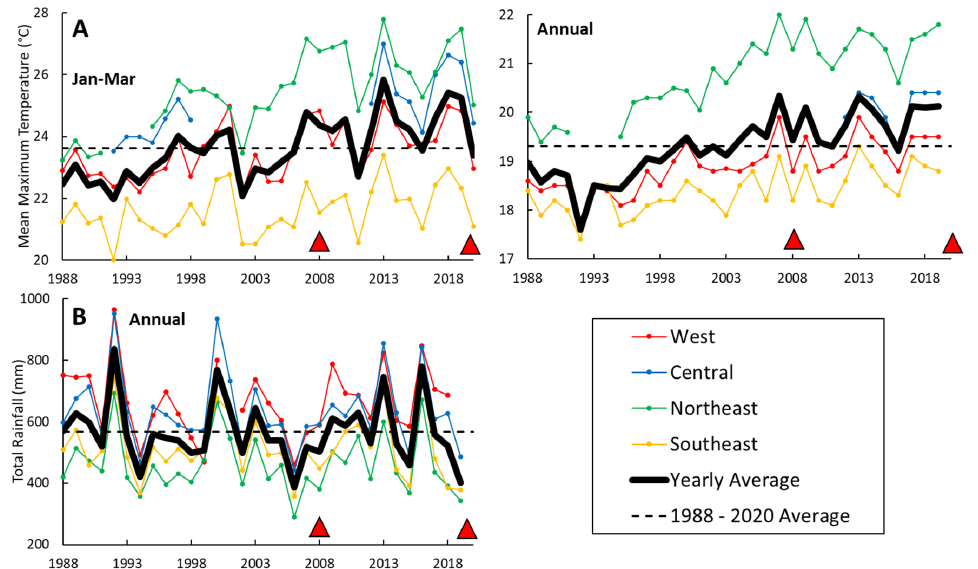
Figure 2. Mean maximum temperatures ( A ) and total annual rainfall ( B ) across Kangaroo Island from 1988-2020. Red triangles indicate the two most widespread fire seasons on record (2008, 2020). Climate data collected from on-island weather stations [6] and merged into regional clusters. West: stations within and near Flinders Chase NP (4 stations); Central: nearby Parndana and Vivonne Bay (9); Northeast: nearby Kingscote (5); Southeast: nearby American River and Cape Willoughby (5). Yearly is the average of these clusters.